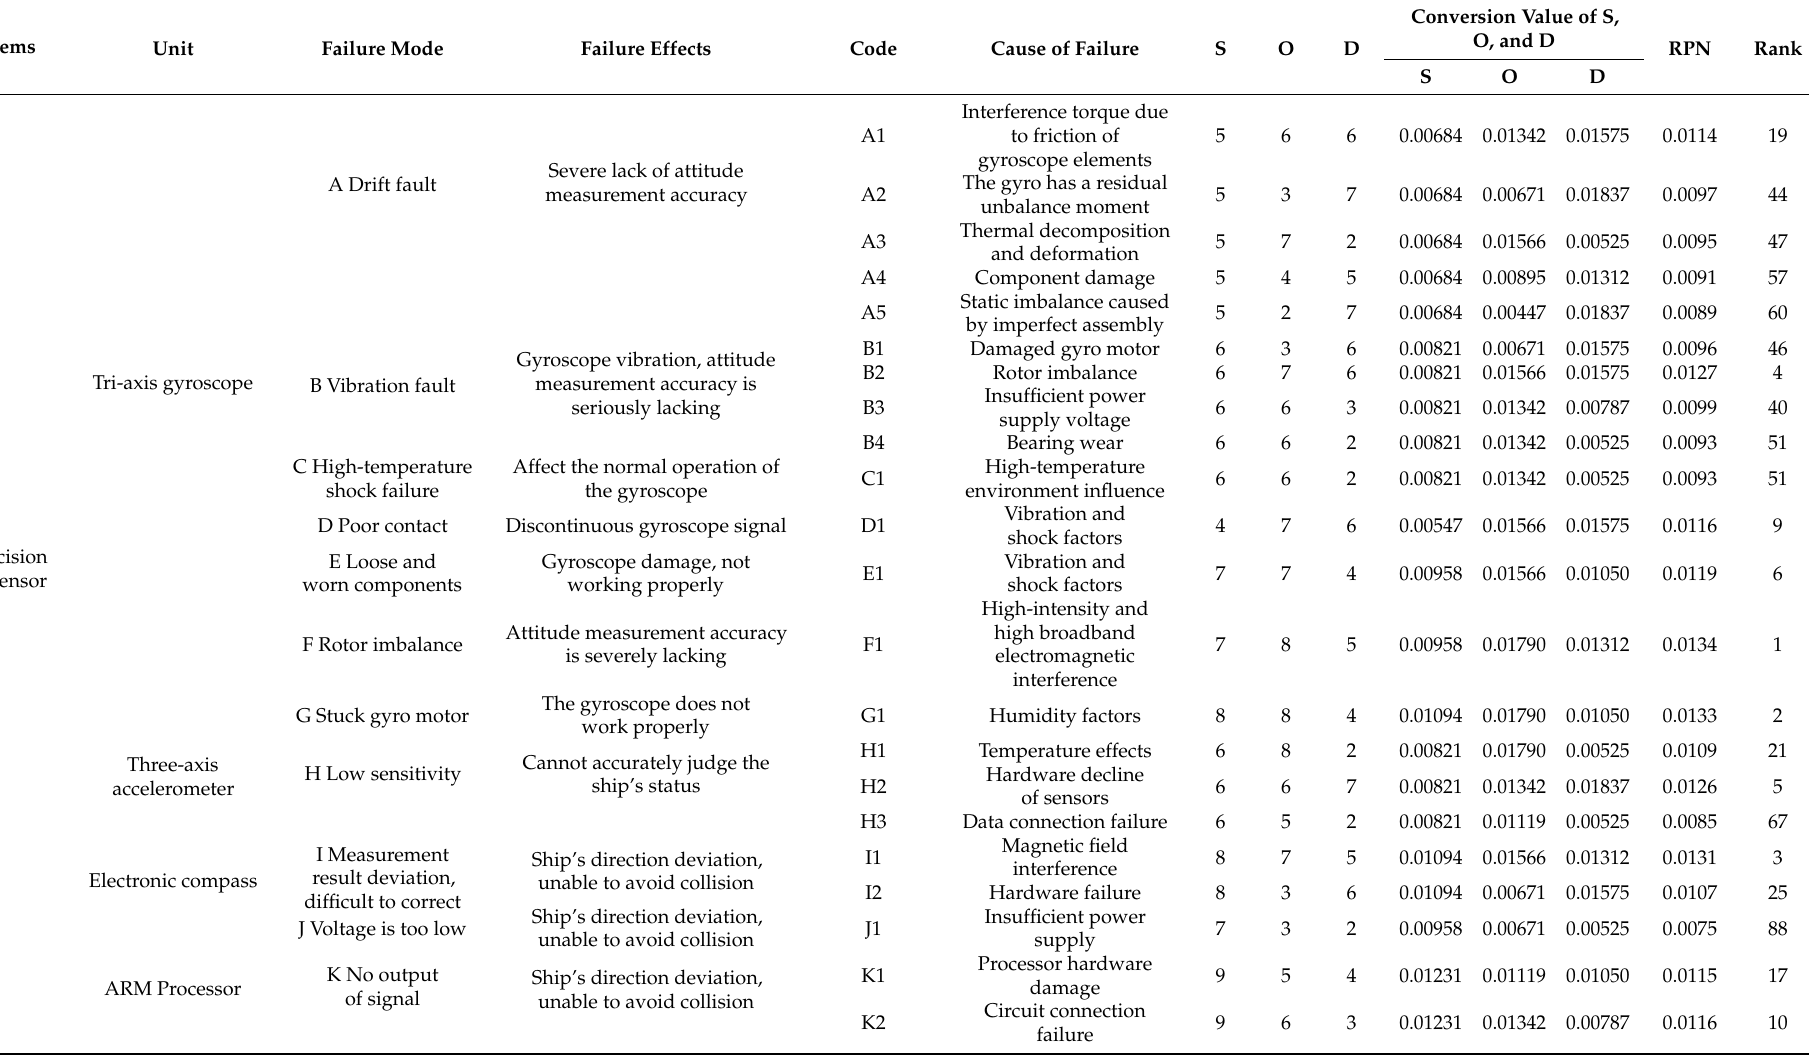
Table 2. FMECA of the positioning system of intelligent